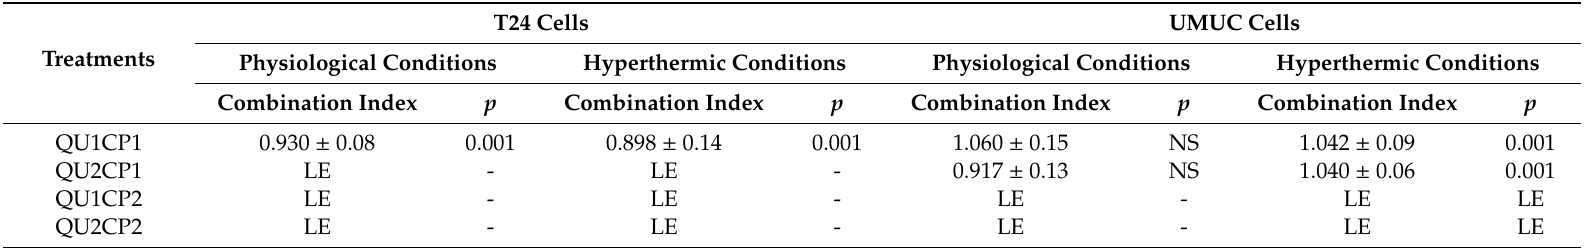
Table 2. Combination index values of the interactions between the inhibitory e ff ect of quercetin and cisplatin under physiological and hyperthermic conditions on colony formation of T24 and UMUC